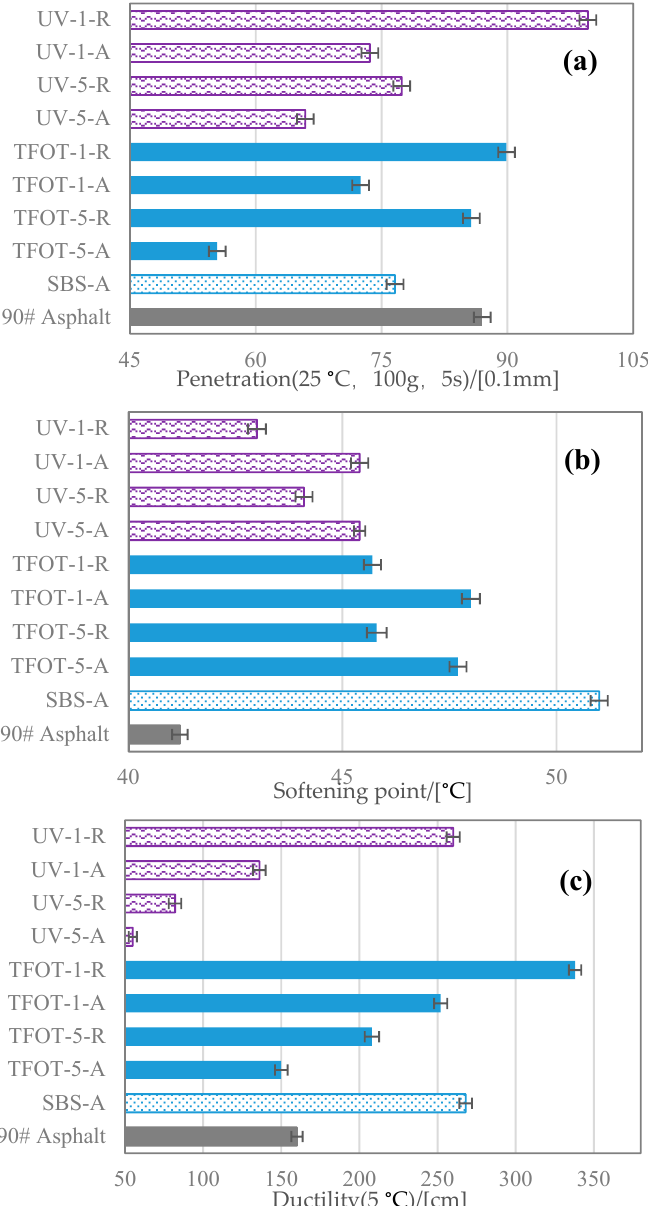
Figure 10. Physical properties of MAAC and MARC samples: ( a ) penetration; ( b ) softening point; ( c ) ductility.